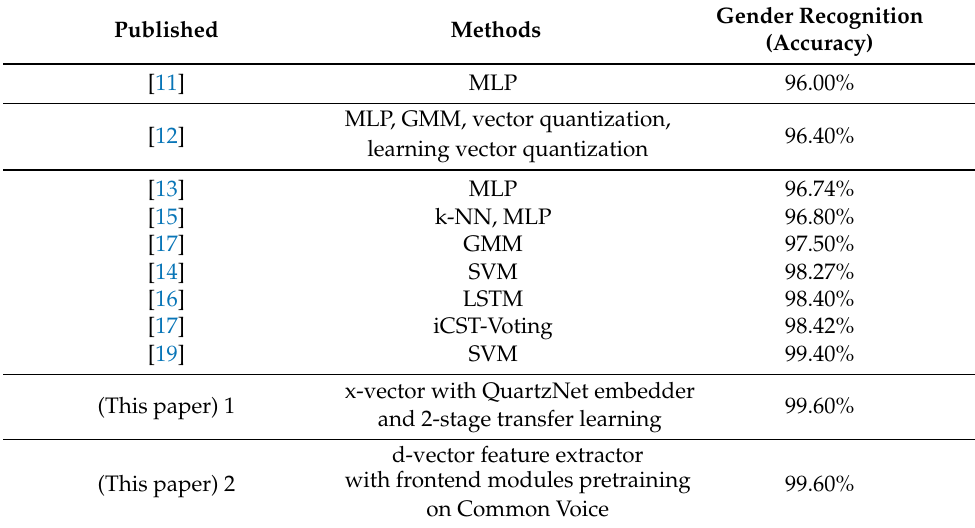
Table 15. Comparison of proposed system with existing ones for gender